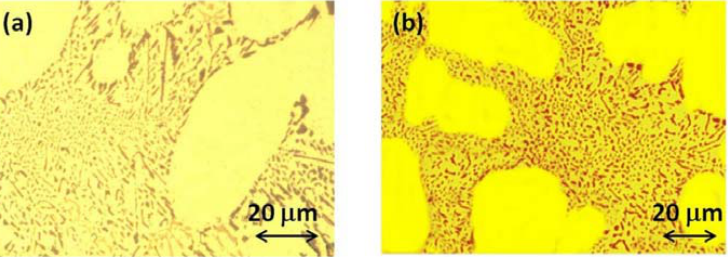
Figure 1. Optical micrographs from the ( a ) as ‐ cast; and ( b ) W specimens. Light and dark contrasts